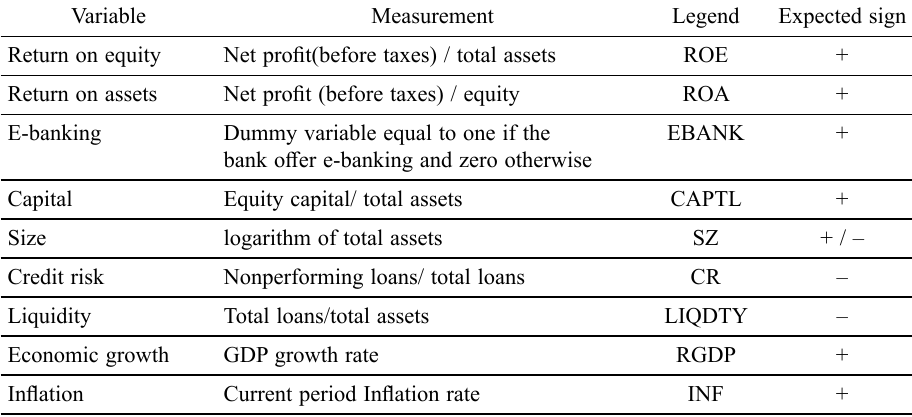
Table 1. Summary of variables used and their specification